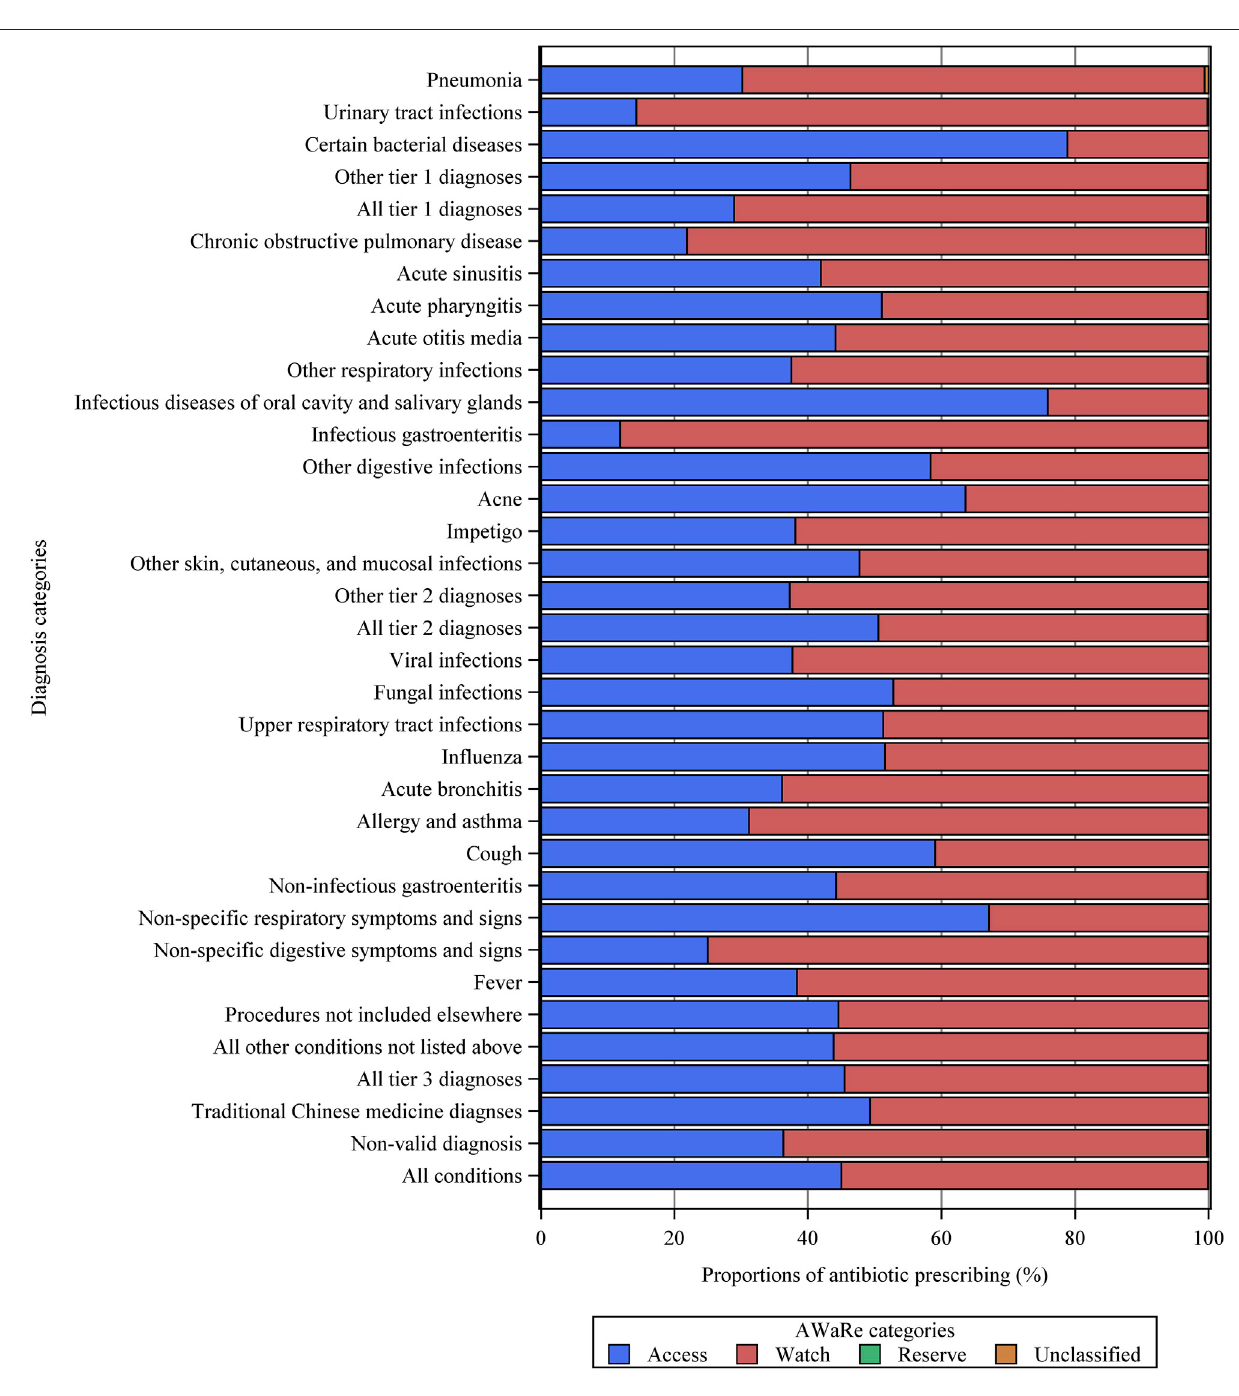
FIGURE2| ProportionsofdifferentAWaRecategoriesofantibioticsforvariousdiagnosticcategories.Othertier1diagnoses=othertier1bacterialinfections.Other respiratory infections = other infectious diseases of the respiratory system categorized in tier 2. Other tier 2 diagnoses = other tier 2 infectious diseases for which an antibiotic may be